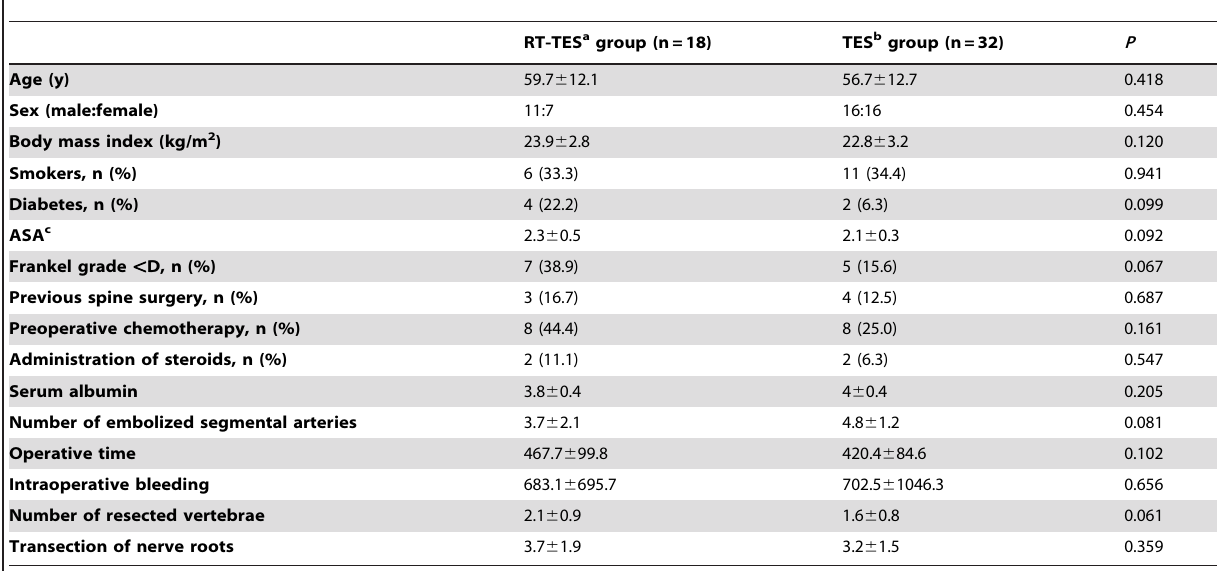
Table 1. Demographic and surgical characteristics of patients.